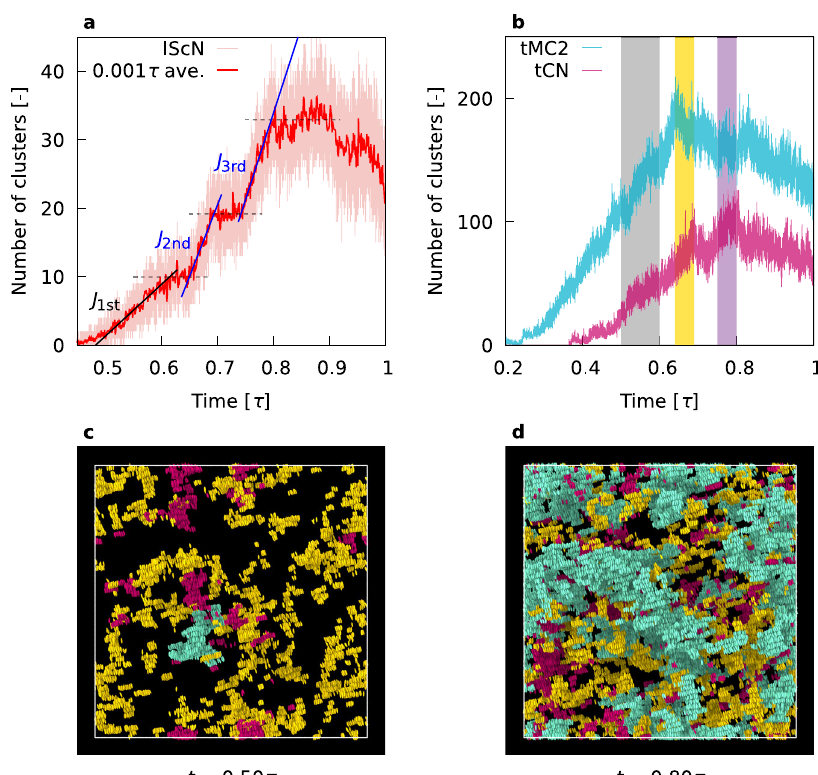
Fig. 4 Multistep nucleation. a Time evolution of the number of IScNs. The averaged number of clusters per 0.001 τ is also plotted as the solid red line. The dashed lines indicate the plateaus. b Time evolution of the number of tCNs and tMC2s. Gray, yellow and violet areas indicate the time range of the fi rst, second and third nucleation, respectively. c , d Snapshots of tMC2s (yellow), tCNs (red) and IScNs (blue) at t = 0.50 τ and 0.80 τ ,